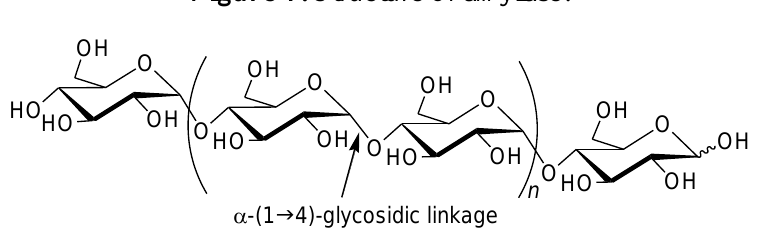
Figure 1. Structure of amylase.